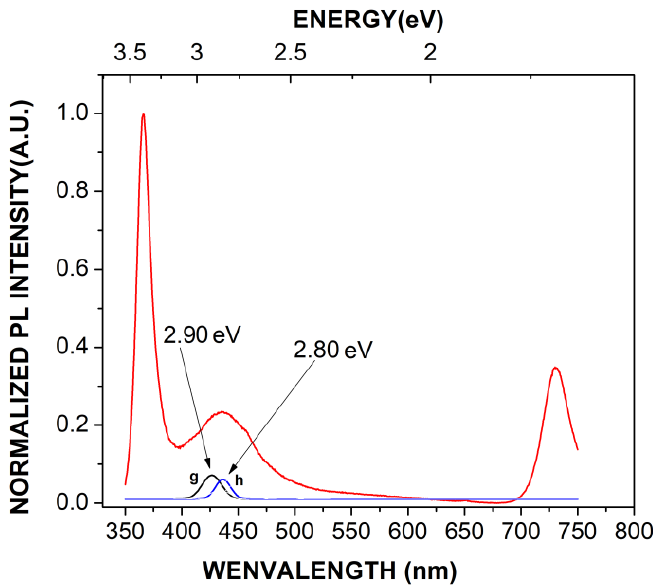
Figure 8. Decomposition of the c peak of the photoluminescence spectrum of the Mg-Zn co-doped GaN powders of Figure 7.